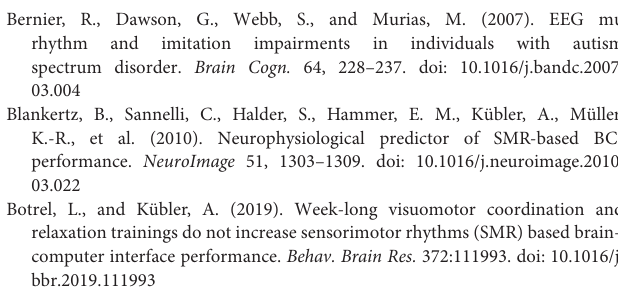
Supplementary Figure 1 | Comparison of two methods to compute the (cid:49) control signal during task execution. The traditional method to quantify how EEG band power changes during task execution is event-related desynchronization. Concretely, the control signal under the ERD definition would be band power normalized by the resting state alpha activity. Here we argue that the control signal using the z-score method would be a better metric by showing that it explains more performance variability. (A) in LR, the correlation coefficient for regression between (cid:49) control signal and PVC was 0.70 in the ERD method and 0.8 in the z-scored method, p < 0 . 05, (B) for UD it was 0.67 and 0.82, p < 0 . 05. Supplementary Figure 2 | Violin plot for performance and SMR. The violin plot provides more detailed information regarding the mean, median and distribution of the data. (A) for LR PVC, (B) for UD PVC, (C) for 2D PVC, (D) for SMR predictor, (E,F) for LR and UD (cid:49) control signal. The blue/red dots represent everyone’s performance, the white dot indicates the median, the blue/red horizontal lines represent the mean, and the violin-like envelop represents the distribution